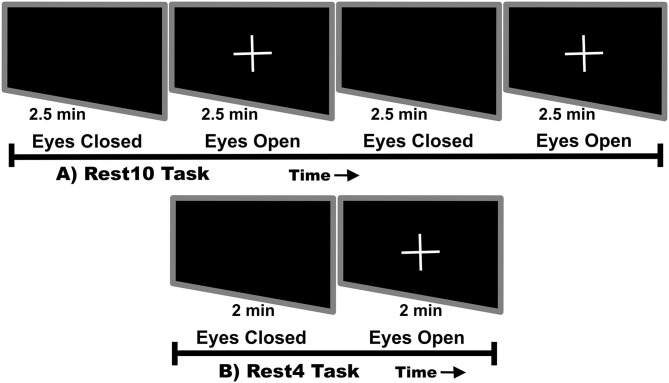
Rest task design. Rest10 alternates between 2.5 min of eyes closed followed by 2.5 min of eyes open fixated on a cross. Rest4 alternates between 2 min of eyes closed followed by 2 min of eyes open fixated on a cross.